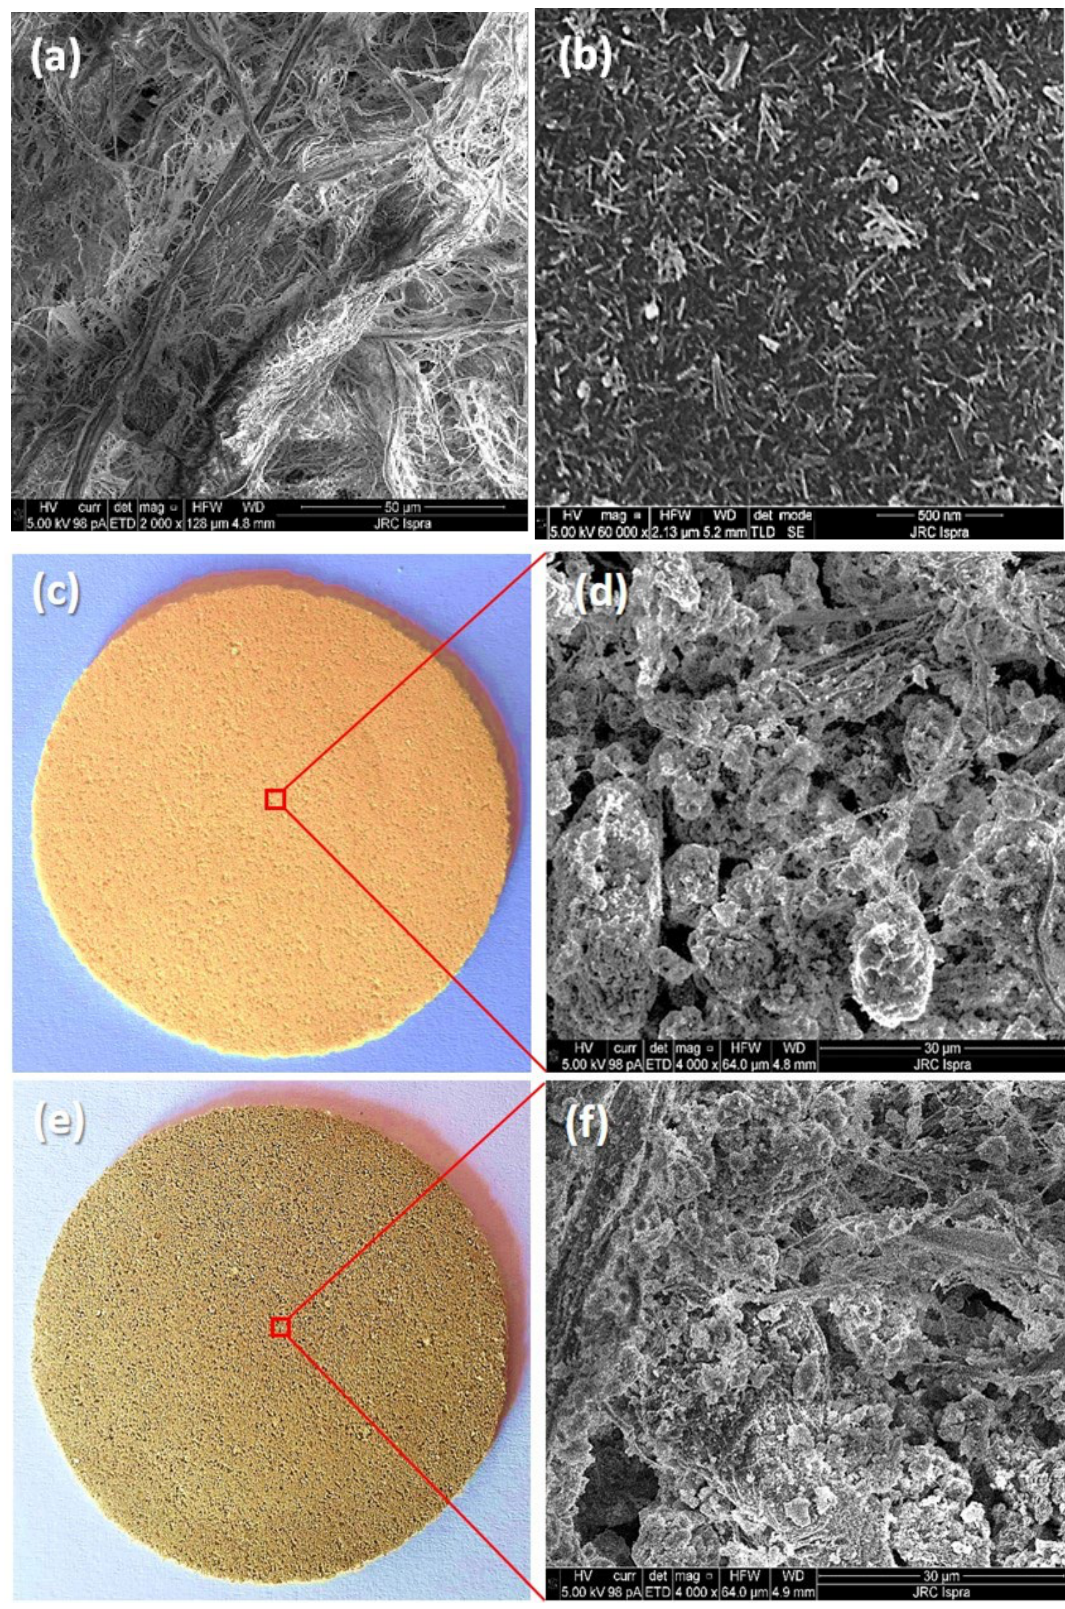
Figure 3. SEM images of neat cellulose ( a ), TiO 2 NW ( b ); photograph and SEM images of TiO 2 NW@Fe 2 O 3 ( c , d ) and TiO 2 NW@CuO ( e , f ) nanocomposite samples. NW@Fe 2 O 3 ( c , d ) and TiO 2 NW@CuO ( e , f ) nanocomposite